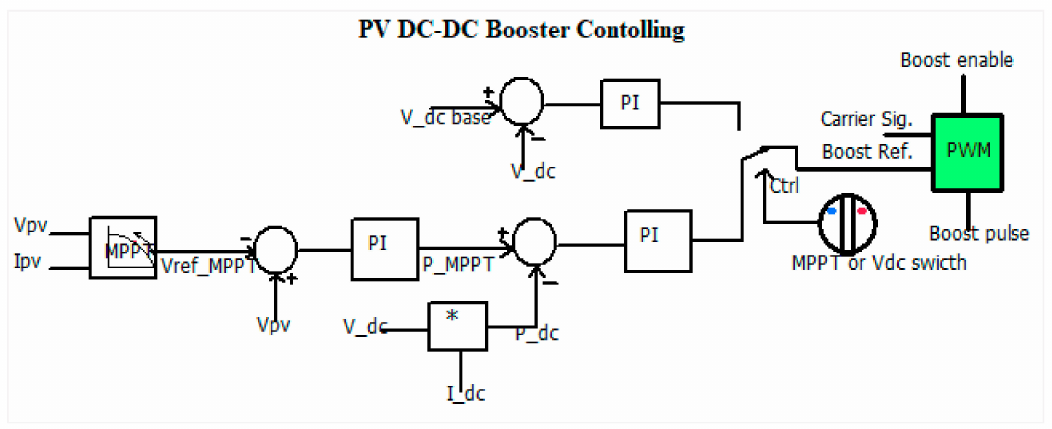
Figure 6. PV DC–DC boost converter controlling diagram.